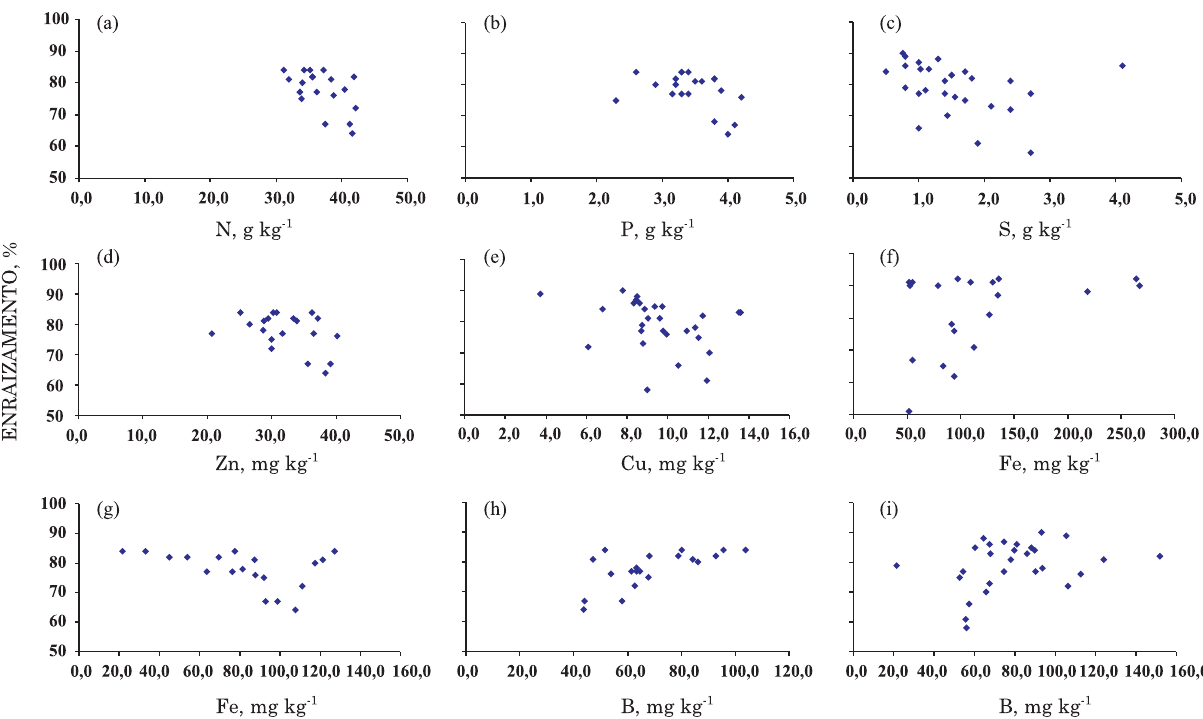
Figura 1. Relação entre o índice de enraizamento e as concentrações de nutrientes nas miniestacas de Eucalyptus , para nitrogênio (a) e fósforo (b) no clone 1213, enxofre no clone 7074 (c), zinco no clone 1213 (d), Cu no clone 7074 (e), ferro nos clones 57 (f) e 1213 (g) e boro nos clones 1213 (h) e 7074